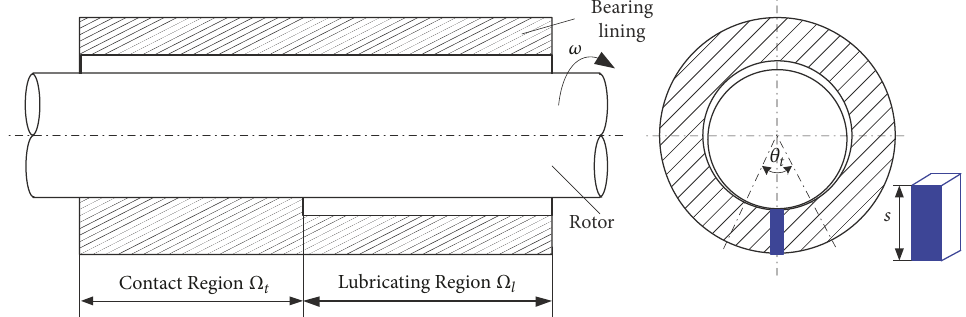
Figure 13: Zoning map of mixed lubricating